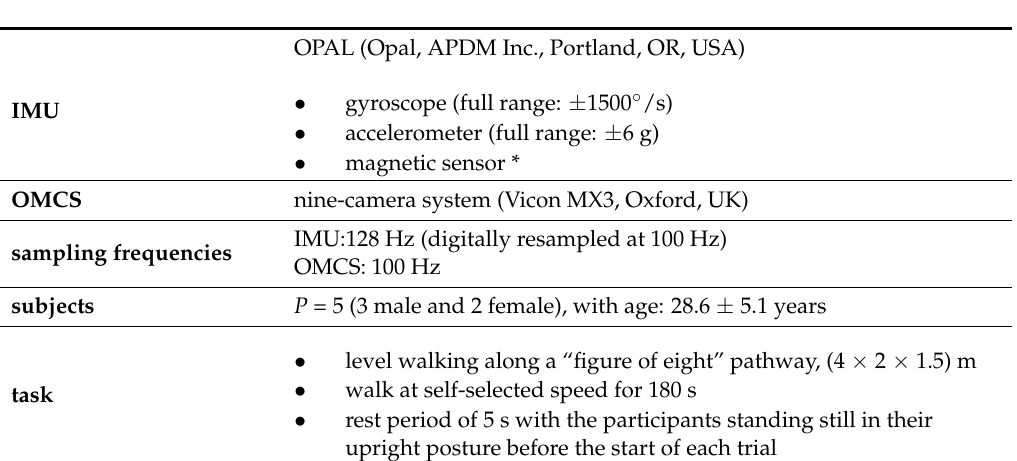
Table 2. Setup and experimental protocol for the OW dataset